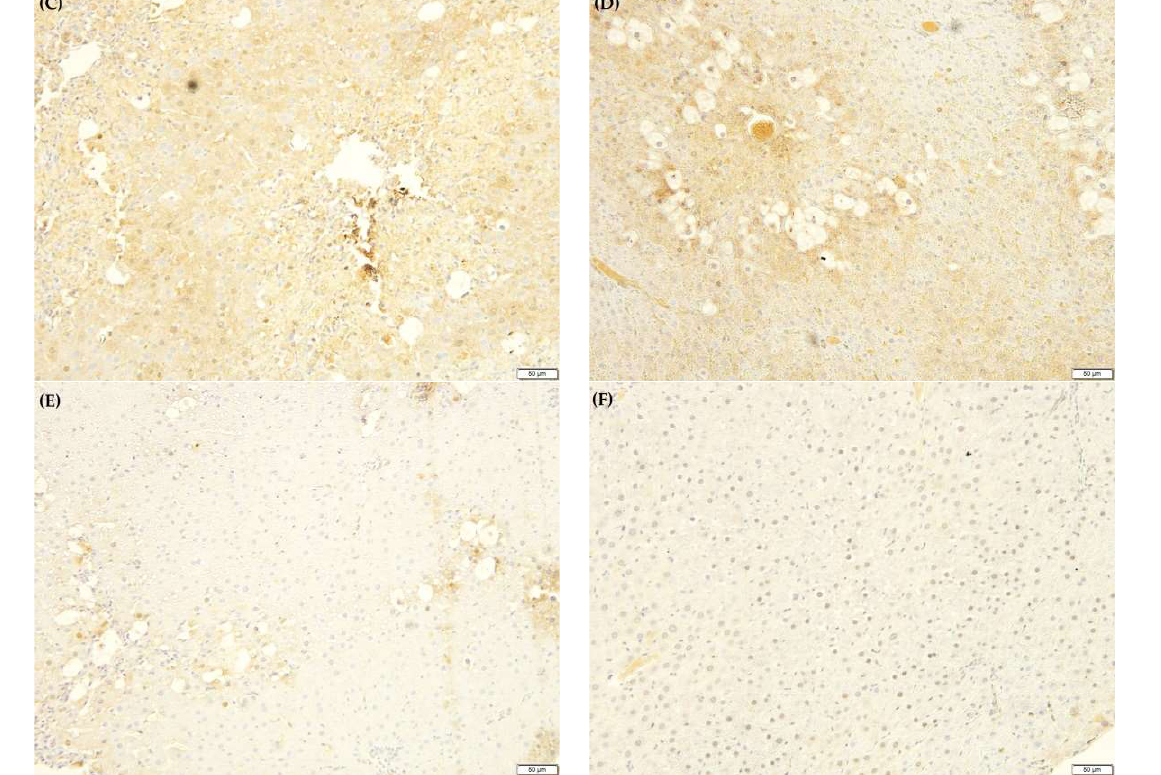
Figure 3. The effect of F. lepicarpa extract on the proinflammatory marker tumour necrosis factor-alpha (TNF-α). Total magnifications 10×. ( A ) Control group, normal. ( B ) CCl 4 (1.0 mL/kg bwt), high expression of TNF-α. ( C ) F. lepicarpa (100 mg/kg bwt + CCl 4 ), low expression of TNF-α. ( D ) F. lepicarpa (200 mg/kg bwt + CCl 4 ), low expression of TNF-α. ( E ) F. lepicarpa (400 mg/kg bwt + CCl 4 ), low expression of TNF-α. ( F ) F. lepicarpa (400 mg/kg bwt, plant control), normal.